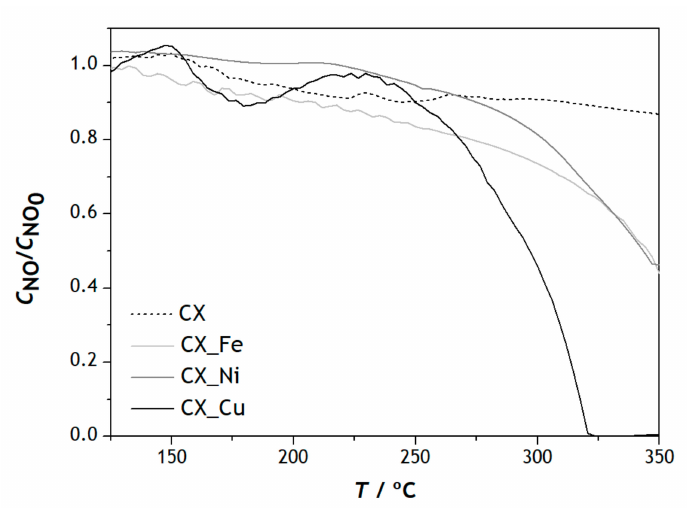
Figure 3. NO concentration in the presence of CX with metals with [NO] = 1000 ppm in He with 5% of O 2